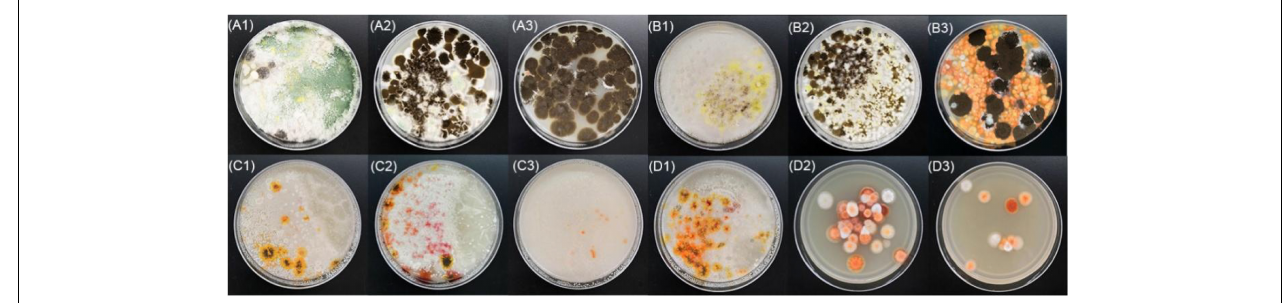
FIGURE 2 | Effect of different growth inhibitors on the enrichment of Monascus from Hongqu BHQ33. Hongqu BHQ33 was added to ferment respectively with different fermentation media containing 10 − 2 . 5 mol/L HCl (A1) , 10 − 2 mol/L HCl (A2) , 10 − 1 . 5 mol/L HCl (A3) , 1.5% (v/v) lactic acid (B1) , 3% (v/v) lactic acid (B2) , 4.5% (v/v) lactic acid (B3) , 3% (v/v) ethanol (C1) , 6% (v/v) ethanol (C2) , 9% (v/v) ethanol (C3) , 1.5% (v/v) lactic acid & 3% (v/v) ethanol (D1) , 3% (v/v) lactic acid & 6% (v/v) ethanol (D2) , 4.5% (v/v) lactic acid & 9% (v/v) ethanol (D3) at 30 ◦ C and 200 r/min for 7 days, and then coated on the modified PDA medium with the fermentation broth to culture for 4 days at 30 ◦ C.